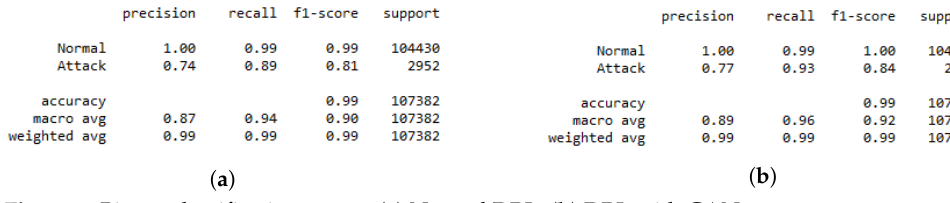
Figure 4. Binary classification report. ( a ) Normal DRL. ( b ) DRL with